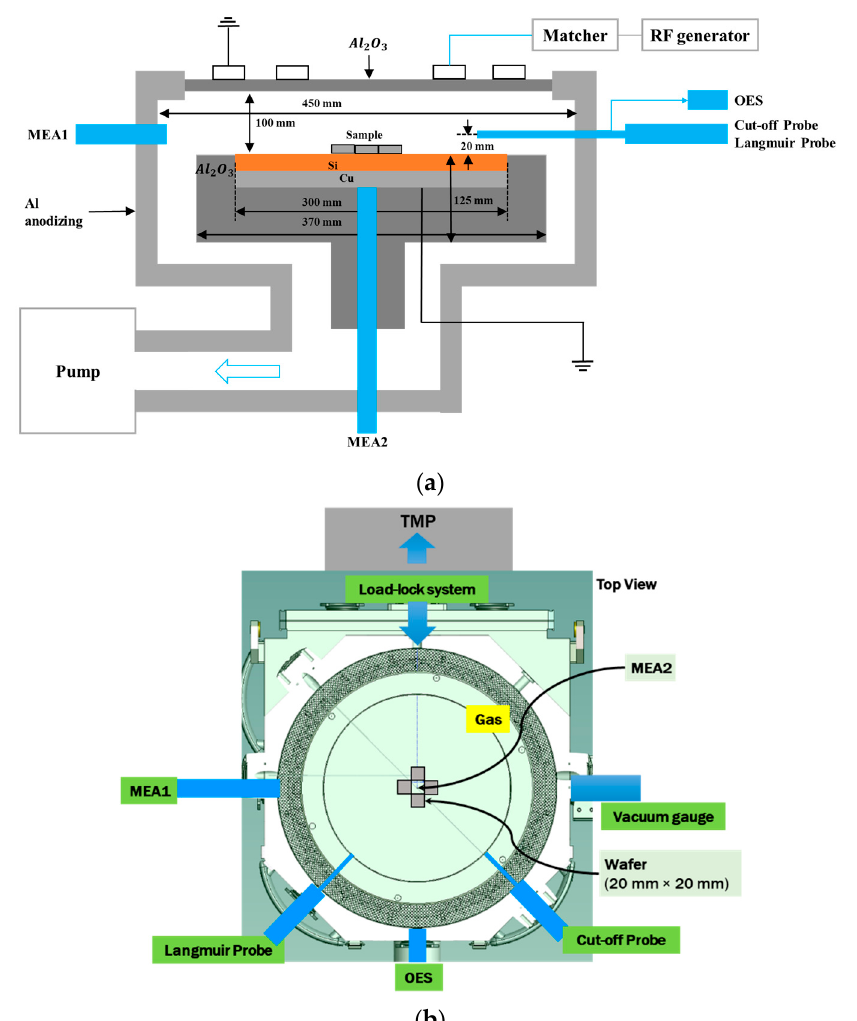
Figure 1. Schematic of the experimental device: Cut-off probe, Langmuir probe, MEA1, and MEA2. ( a ) side view, ( b ) top view.